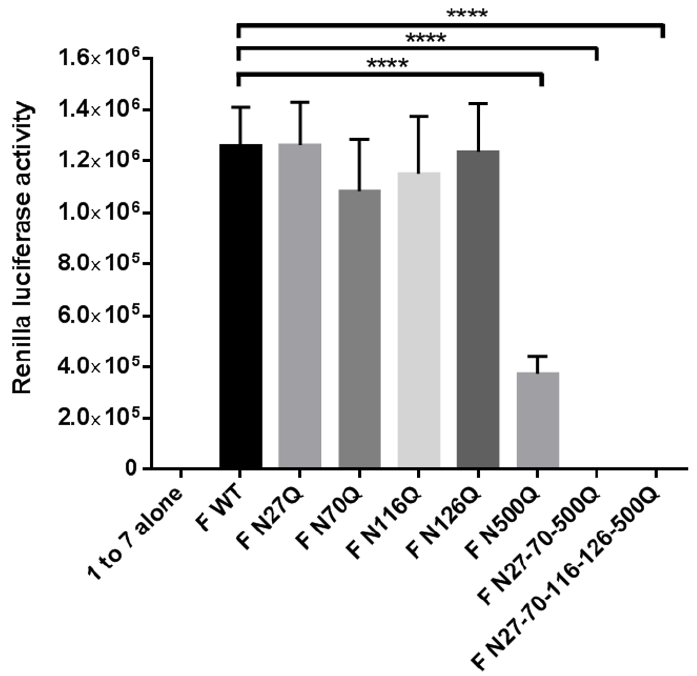
Figure 5. Dual split protein assay to measure RSV F fusion activity. HEK293T cells were transfected with one of the RSV F plasmids as well as the 1–7 fragment of rLuc-GFP or with the 8–11 fragment of rLuc-GFP which corresponds with effector cells and target cells, respectively. After 48 h incubation, the effector and target cells were washed, resuspended in media and further co-cultured. The activity of the reconstituted Renilla luciferase in fused cells was measured after 16–24 h by adding cell-permeable coelenterazine. Five co-culturing replicates were performed for each biological condition. Data represents the mean values ( ± SD) of five co-culturing replicates. **** p < 0.0001 (Student’s unpaired two-tailed t test).